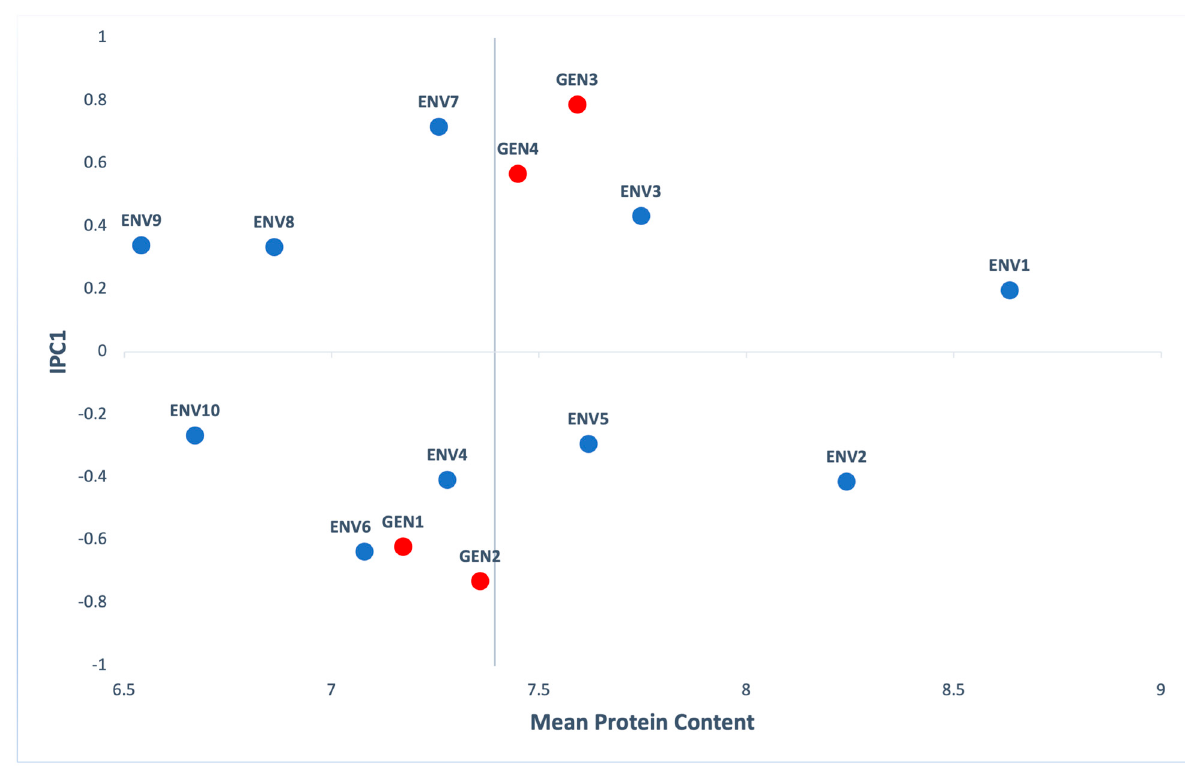
Figure 4. AMMI biplot presenting mean protein content and the first interaction principal components axis (IPC1) of 4 genotypes (red) evaluated in 10 environments (blue).